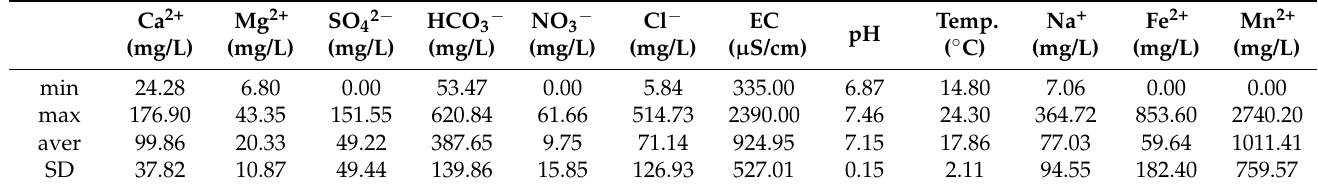
Figure 16. Chloride ion (Cl − ) distribution map (mg/L) of the confined aquifer (October 2019). Table 1. Statistical analysis of some of the major chemical constituents from groundwater samples (May 2019) (unconfined aquifer).